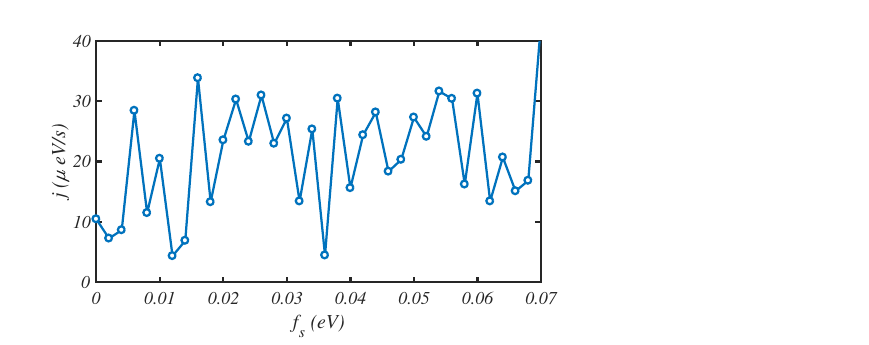
Figure 4. The fluctuation of energy flux, j , through a protein chain of N = 150 sites, for different values of the solvent parameter, f s , at T = 300 K.